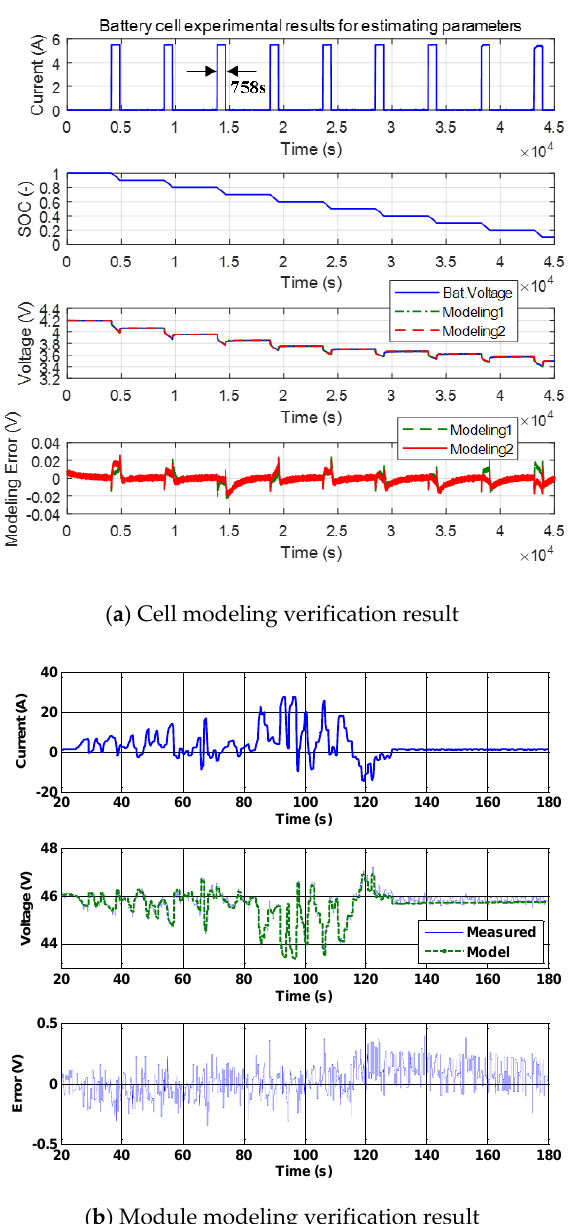
Figure 10. Modeling verification results of the battery ’s cell and module.